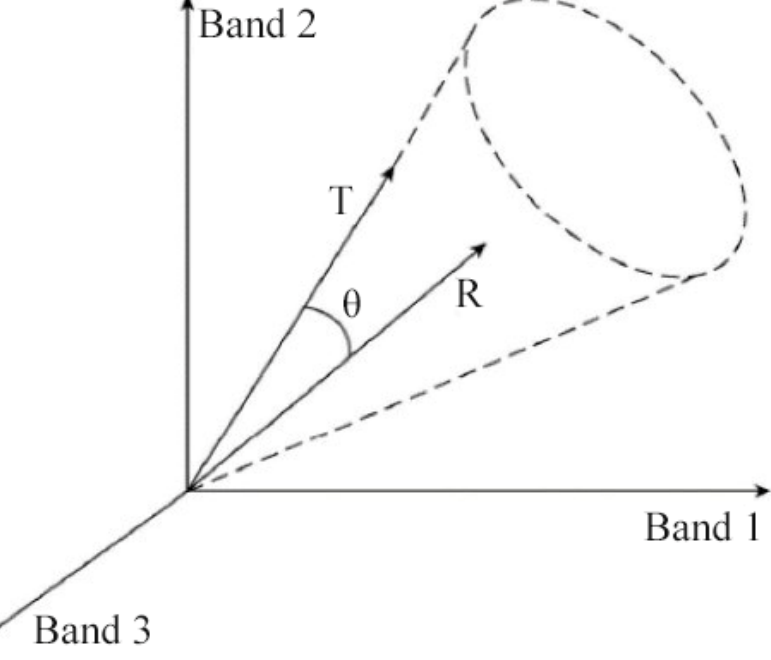
Figure 7. Schematic diagram of the SAM recognition classification principle.